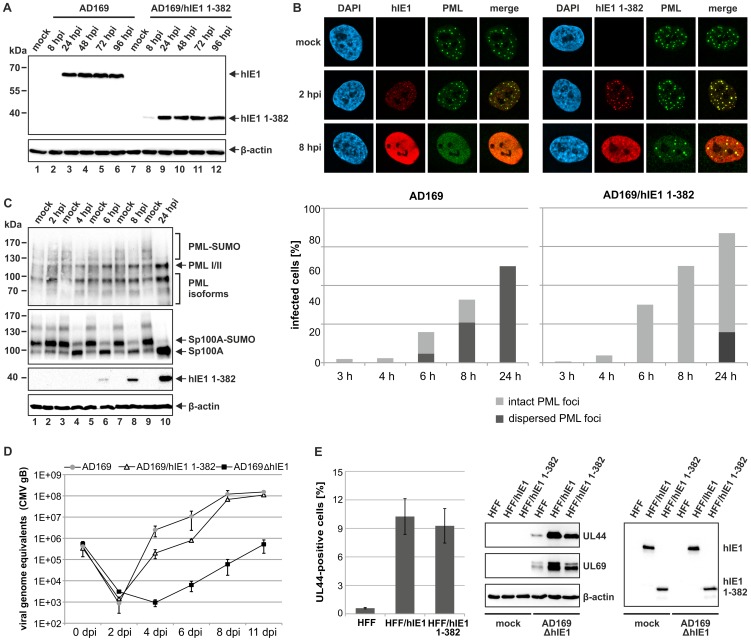
Analysis of IE1CORE during human cytomegalovirus replication.(A) Western blot analysis showing the expression kinetics of full-length hIE1 or hIE1CORE(1–382) after infection of HFFs with wild-type HCMV (AD169) or recombinant HCMV expressing truncated hIE1 (AD169/hIE1 1–382) (MOI 0.2). (B) PML-NB dispersal after infection of HFFs with either AD169 or AD169/hIE1 1–382. Upper panel: immunofluorescence detection of hIE1 and PML at 2 and 8 hpi with the respective viruses (MOI 0.5). Lower graph: quantification of the number of infected cells containing either intact or dispersed PML foci during the first 24 h after infection. (C) DeSUMOylation of PML and Sp100 after infection of HFFs with AD169/hIE1 1–382 (MOI 3). Western blot detection of PML and Sp100 (upper panels) as well as hIE1 1–382 and β-actin (lower panels) during the first 24 hpi. (D) Growth curve analysis of wild-type AD169, AD169/hIE1 1–382 and IE1-deleted HCMV (AD169ΔhIE1). HFF cells were infected with wild-type AD169 at a low MOI (MOI 0.01) and equivalent genome copies of AD169/hIE1 1–382 and AD169ΔhIE1. Cell supernatants were harvested at indicated times and analyzed for genome copy numbers by quantitative real-time PCR. (E) Complementation of AD169ΔhIE1 by hIE1 1–382. Left panel: HFFs or HFFs expressing either hIE1 or hIE1 1–382 were infected with AD169ΔhIE1 at a low MOI (MOI 0.01). The cells were fixed at 48 hpi followed by immunofluorescence staining of UL44 and quantification of cells exhibiting viral gene expression using the ImageJ software. Middle and right panel: Western blot analysis of UL44, UL69, β-actin and IE1 expression in HFF, HFF/hIE1 or HFF/hIE1 1–382 cells after either mock infection or infection of with AD169ΔhIE1 as indicated.